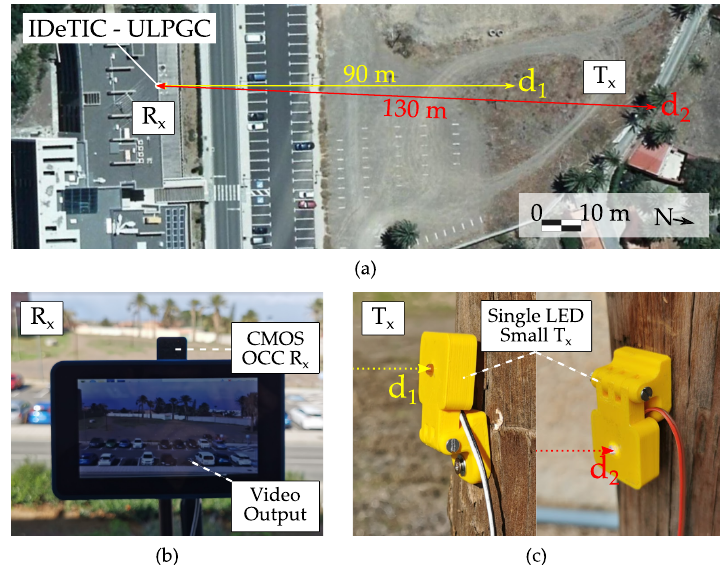
Figure 9. Photographs of the communication devices deployed for the sub-pixel experiments at the facilities of IDeTIC. ( a ) Satellite image from Cartográfica de Canarias (Grafcan) [53]. ( b ) CMOS camera receiver. ( c ) single LED small